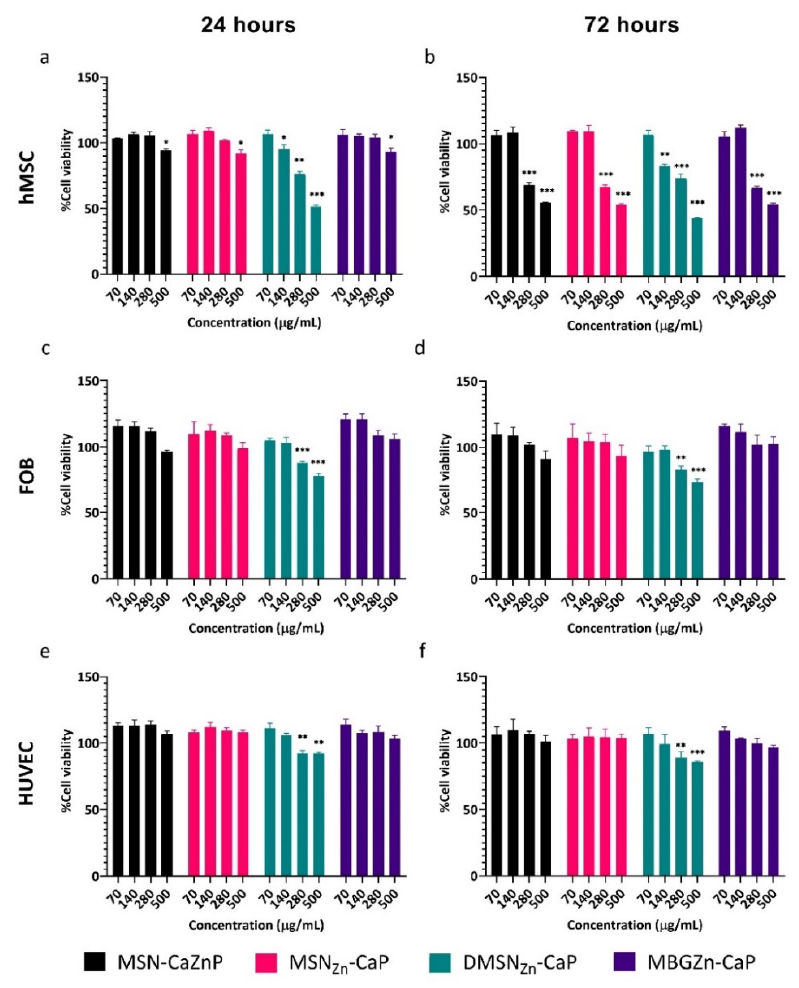
Figure 4. Metabolic activity of hMSC ( a , b ), FOB ( c , d ) and HUVEC ( e , f ) measured using the MTT assay after 24 and 72 h exposure to MSN-CaZnP, MSN Zn -CaP, DMSN Zn -CaP and MBGZn-CaP to concentrations ranging between 70 and 500 µ g/mL. Cell viability is shown as % compared to control cells (not incubated with nanoparticles). Significant differences between samples and control groups are Significant differences between samples and control groups were calculated by two-way ANOVA followed by Turkey’s multiple comparison, * representing p -values as follows; * p < 0.033; ** p < 0.02; *** p <